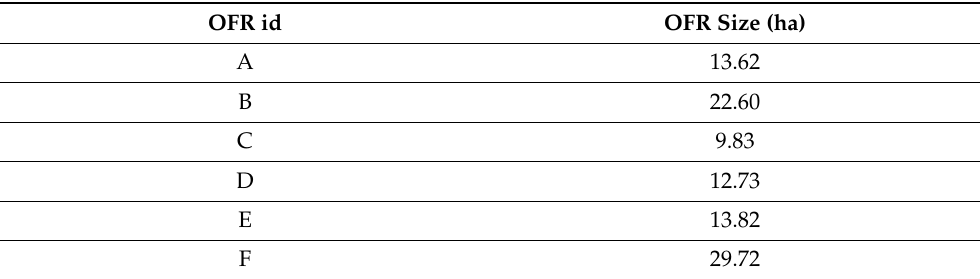
Table 2. Selected OFRs to illustrate PlanetScope, Basemap, and Planet Fusion surface area time series and their size according to the OFR